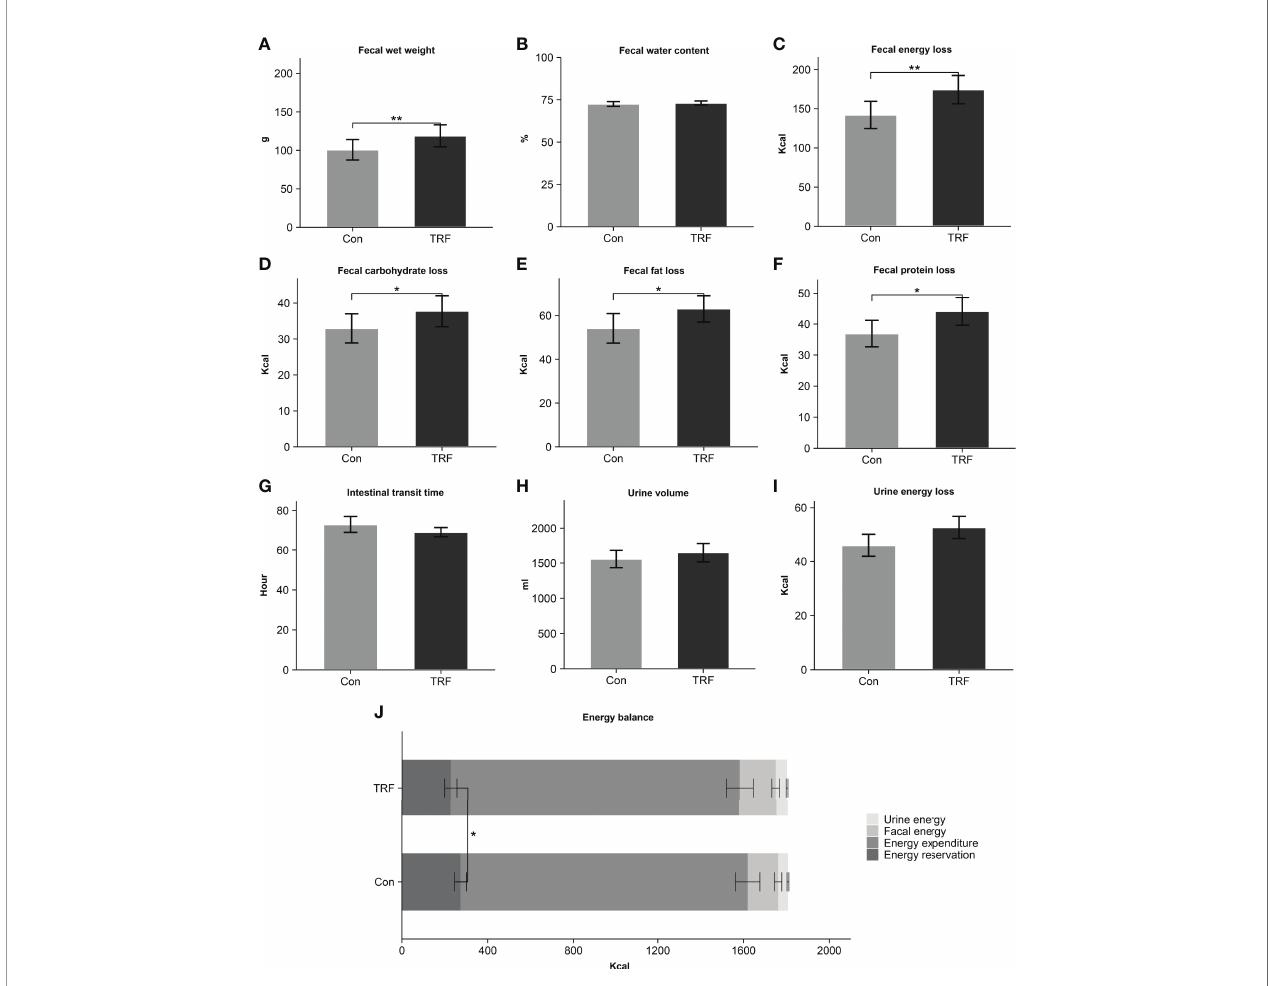
FIGURE 3 | Fecal wet weight (A) , fecal water content (B) , fecal energy loss (C) , fecal carbohydrate loss (D) , fecal fat loss (E) , fecal protein loss (F) , intestinal transit time (G) , urine volume (H) , urine energy loss (I) , and energy balance (J) between control and TRF groups. Data are mean ± SEM, *P <0.05,